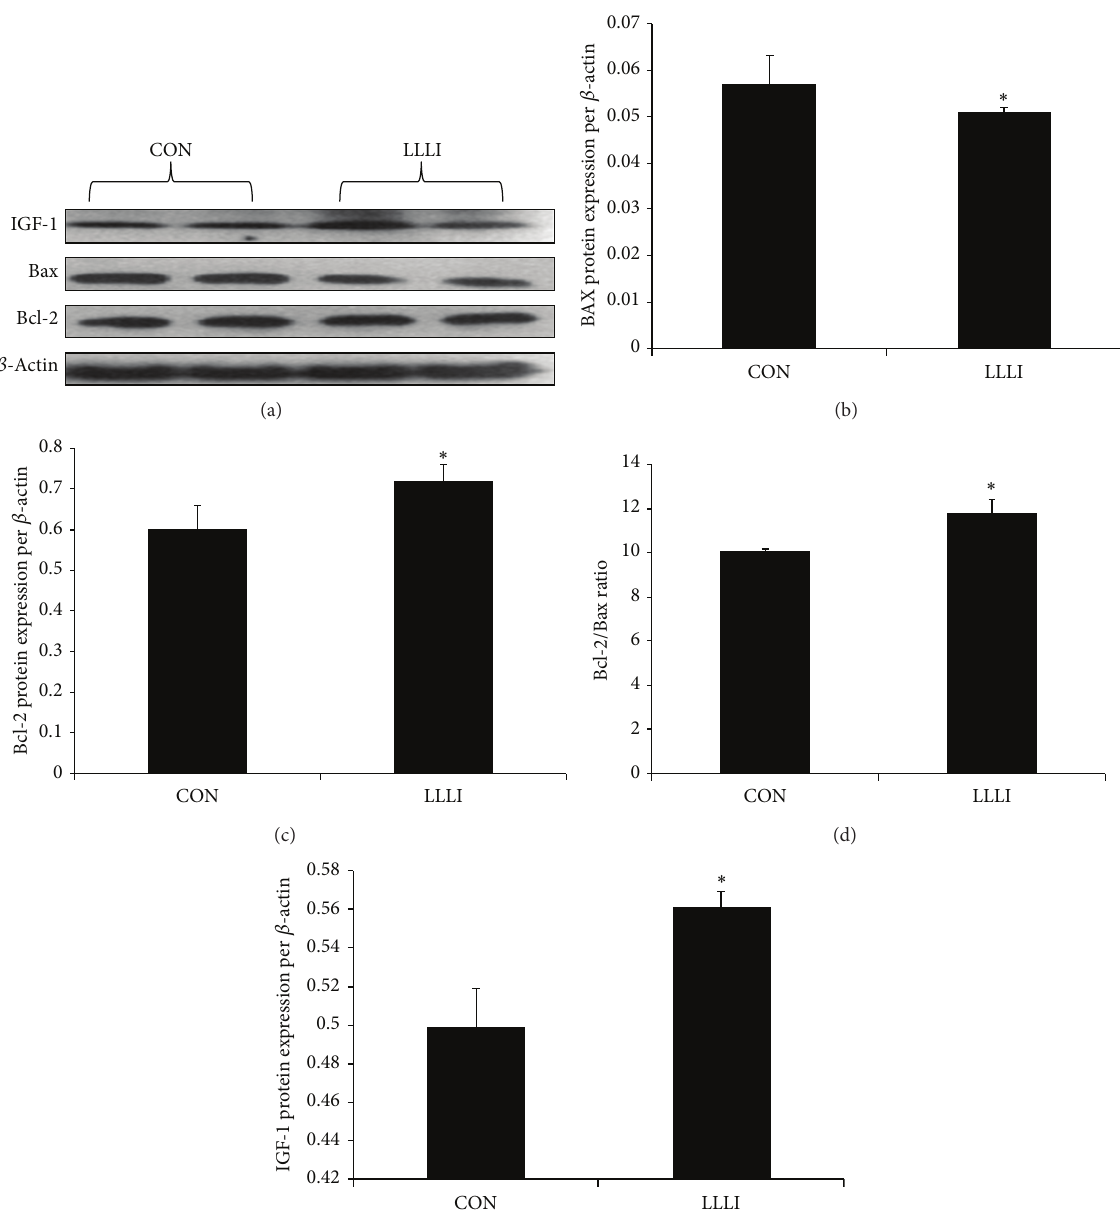
Figure 1: Western blot analysis and densitometry ratios of BAX, Bcl-2, and IGF-1 in gastrocnemius. Western blot analysis is used to determine the level of proteins extracted from gastrocnemius, relative to the endogenous control 𝛽 -actin. Western blots and values are means ± SE representative from one rat from each group. 𝑛 = 10 for each group. ∗ 𝑃 < 0.05 versus control group.